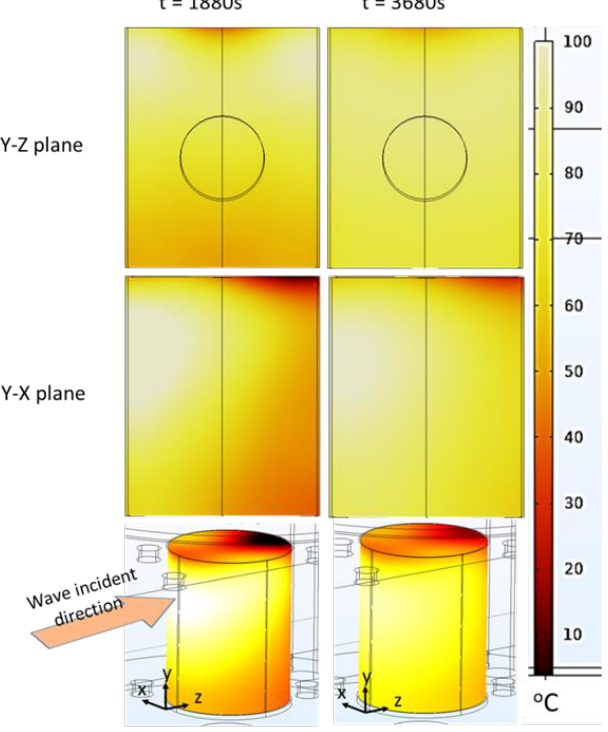
Figure 12. 2D Temperature cartography at the end of the ramp-up heating (1880 s) process and temperature-holding phase (3680 s) (each plan passed through the centerline); 3D temperature map of the sample at 3680 s (simulation with hc 3 value).